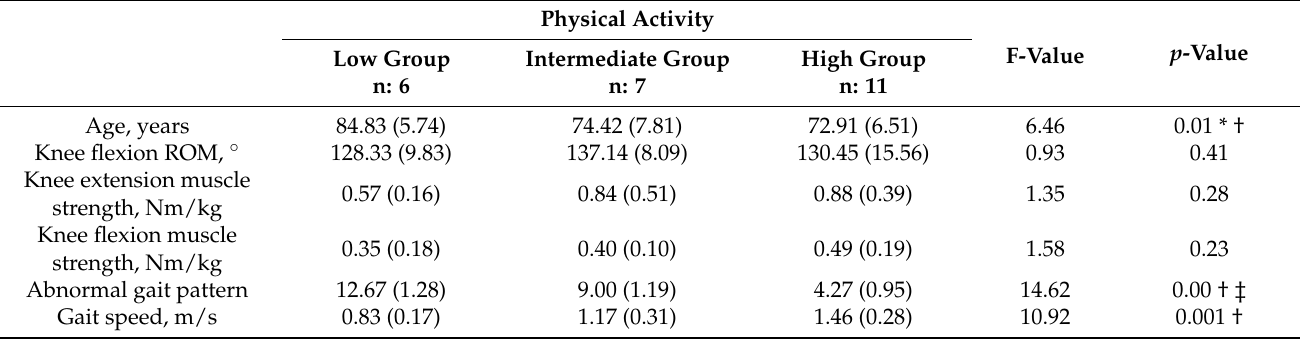
Table 2. Relationship of physical